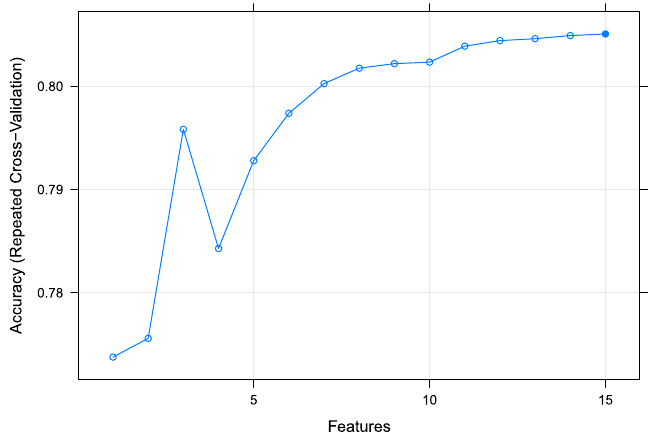
Figure 1. Illustration of the recursive feature elimination results incorporating 1 to 15 features. A random forest method was used to predict the udder health status of dairy cows according to somatic cell count below or above 200,000 cells/mL. The number of features included within the model is reported on the x-axis and the accuracy of the model from tenfold cross validation repeated 100 times is on the